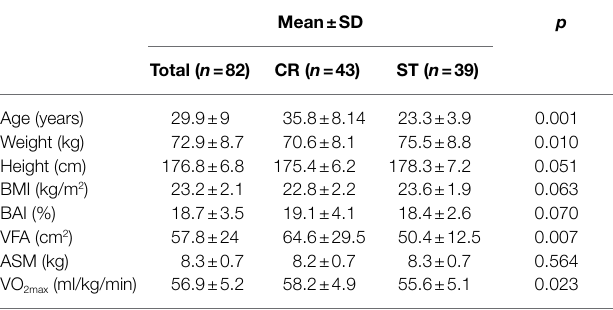
TABLE 1 | Characteristics of the study participants.